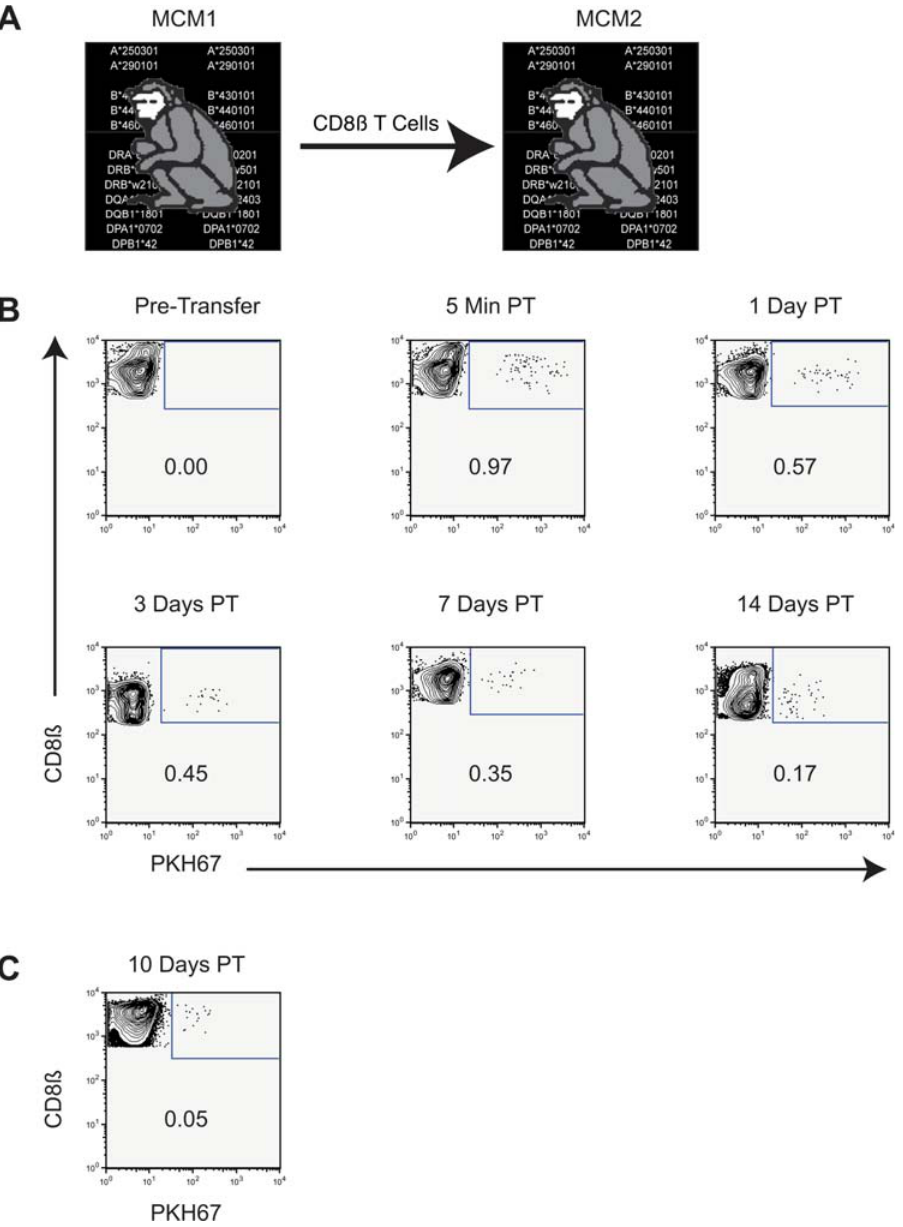
Figure 3. Allogeneic transfer from MCM1 to MCM2 . A Diagram displaying the transfer protocol. B PKH67 + donor cells from MCM1 in PBMC of recipient 2-MHC-haplotype-matched MCM2. Dot plots are gated on lymphocytes and display CD8ß + lymphocytes only. C Right Axillary lymph node sample 10 days post-transfer.